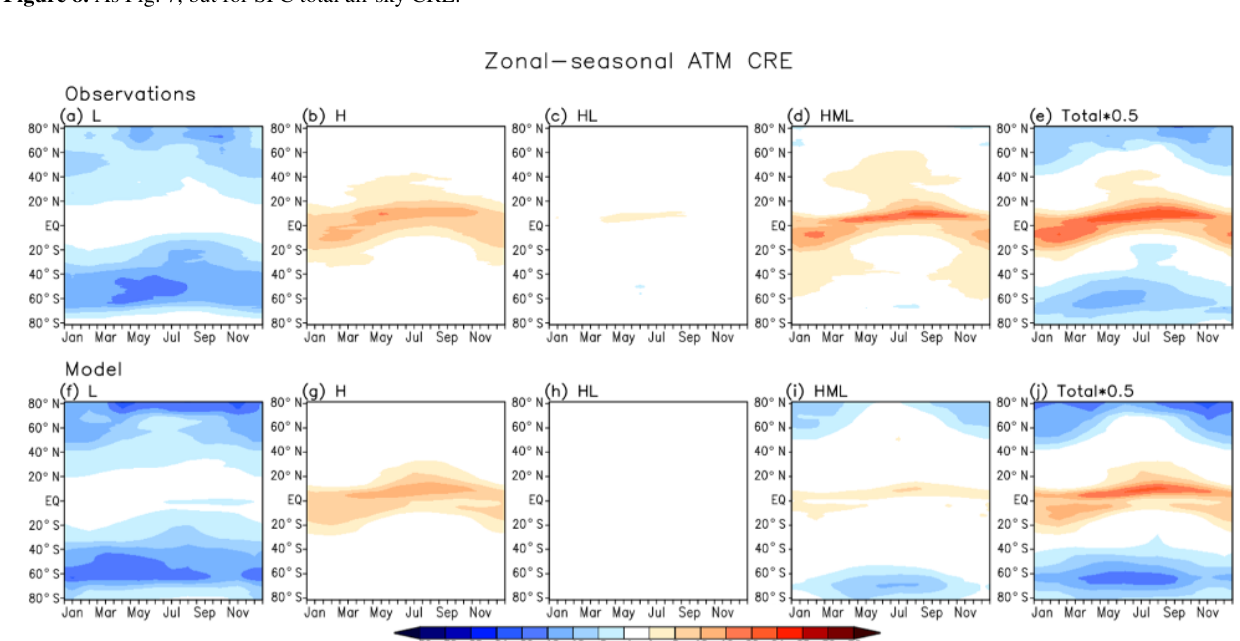
Figure 8. As Fig. 7, but for SFC total all-sky CRE.